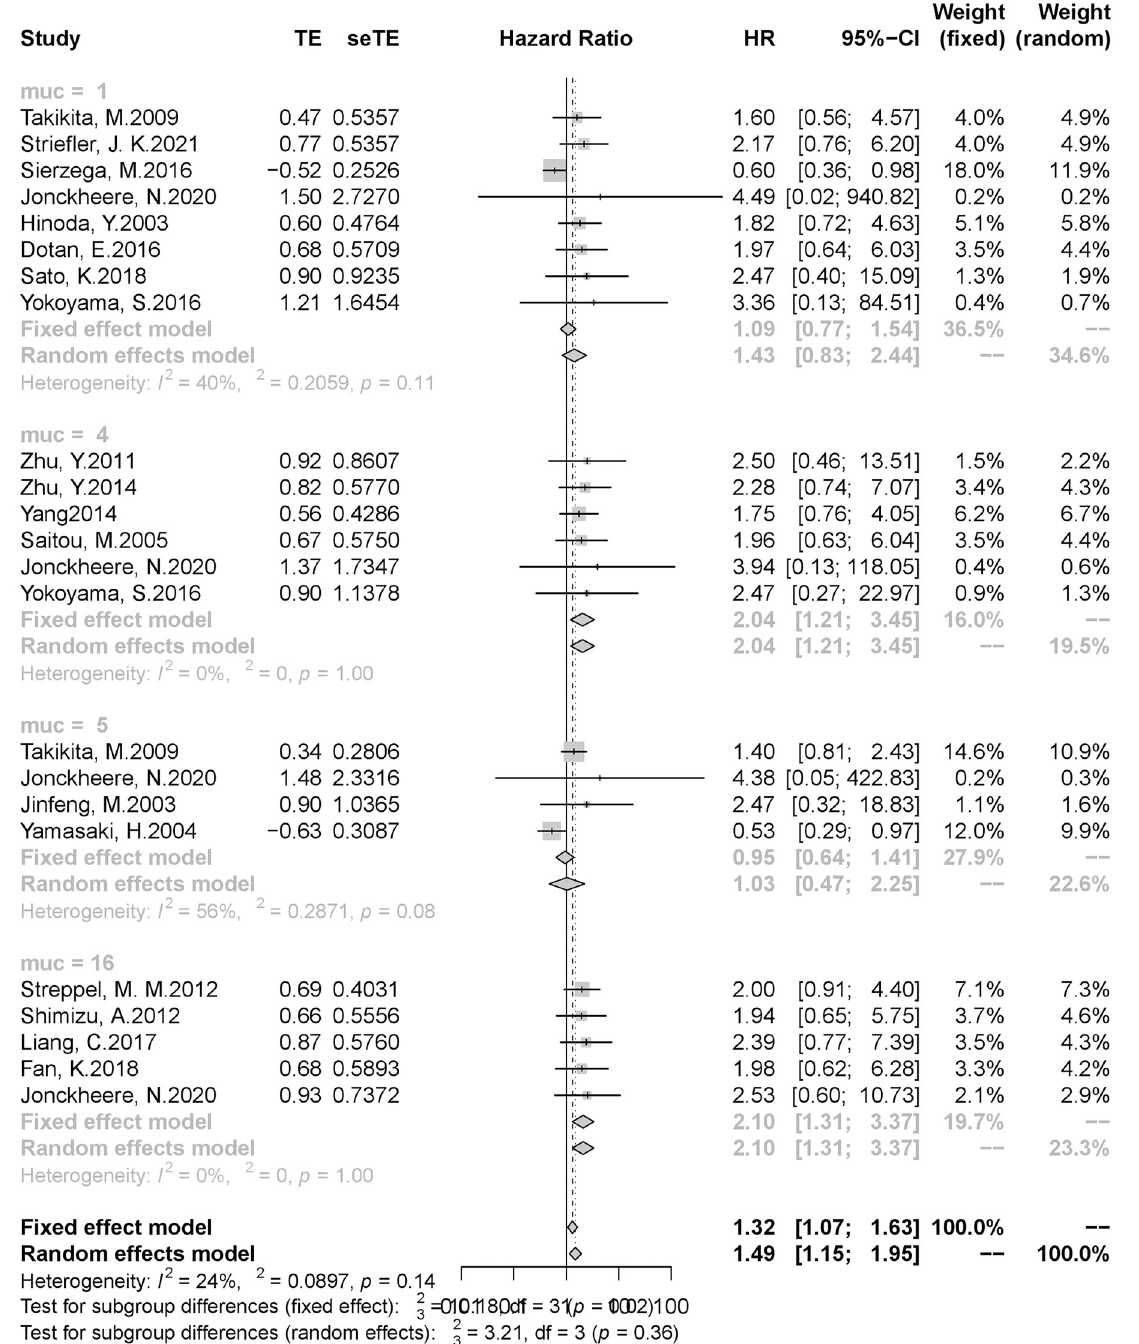
Fig 3. Result of subgroup analysis (1). (A)Subgroup analysis was performed by mucin subtype. (B) muc = 1 , mucin1. muc = 4, mucin4. muc = 5, mucin5. muc = 16 , mucin16. (C)MUC1: HR = 1.09,95% CI 0.77–1.54; MUC4: HR = 2.04,95%CI 1.21–3.45; MUC5: HR = 1.03,95%CI 0.47–2.25; MUC16: HR = 2.10,95%CI 1.31–3.37.